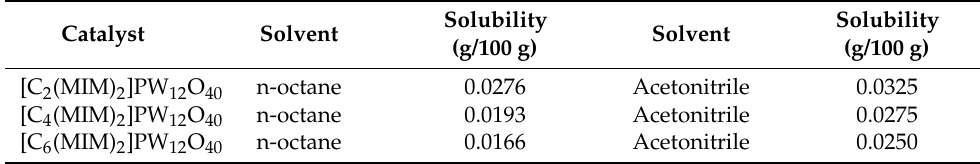
Table 4. Solubility of catalyst in n-octane and acetonitrile.